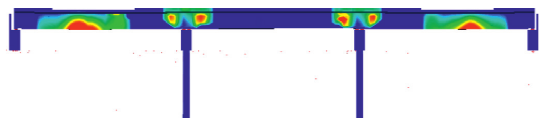
Figure 27: Principal normal strain at the end of the analysis, “model A3-C-N.”